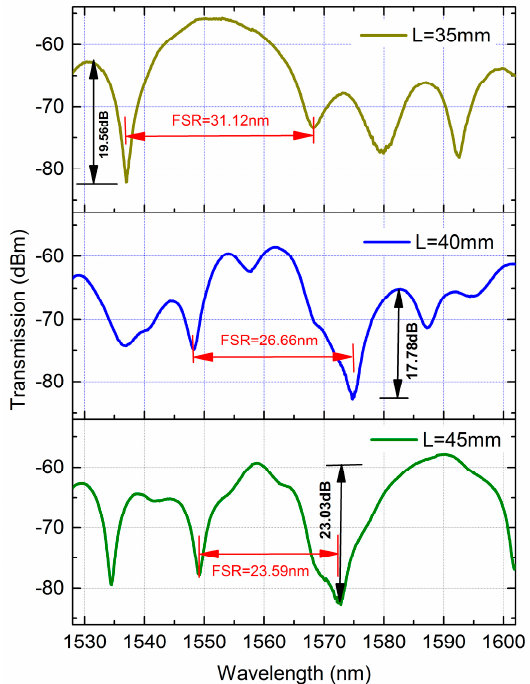
Figure 3. Transmission spectra of the proposed MZI with different length of PCF.